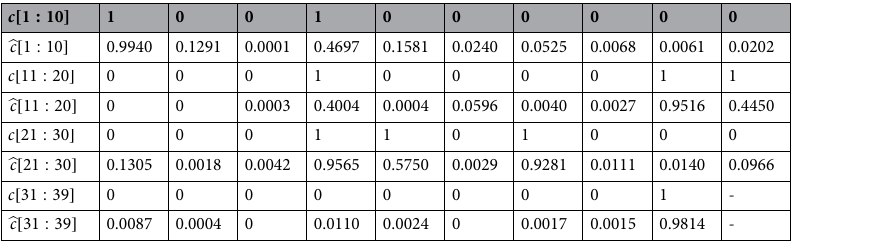
c is its (cid:31)